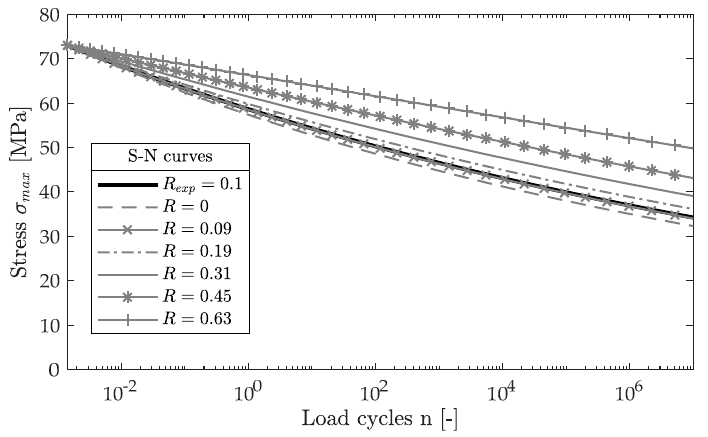
Figure 17. Approximated S-N-curves for the simplified TWIST load spectrum for the 90° plies in the micro model.